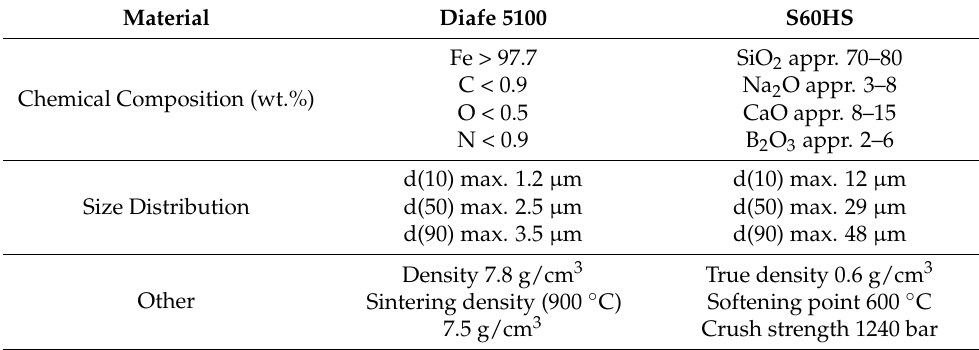
Table 1. Properties of the used raw materials [33,34].